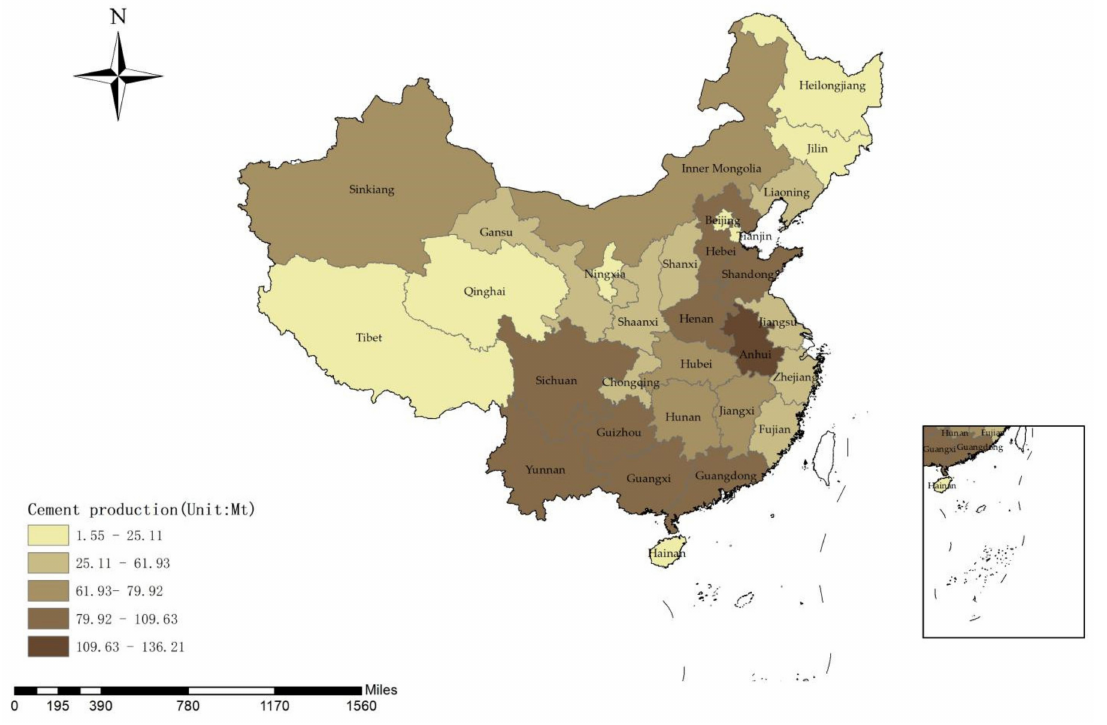
Figure 4. Cement production capacity by province in China in 2020 (Mt/y) (reproduced according to